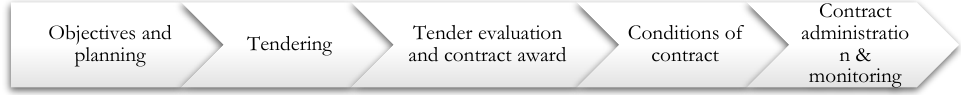
Figure 1. Stages of construction procurement (adapted from Akintoye and Main [33] and the International Organisation for Standardisation [34]).